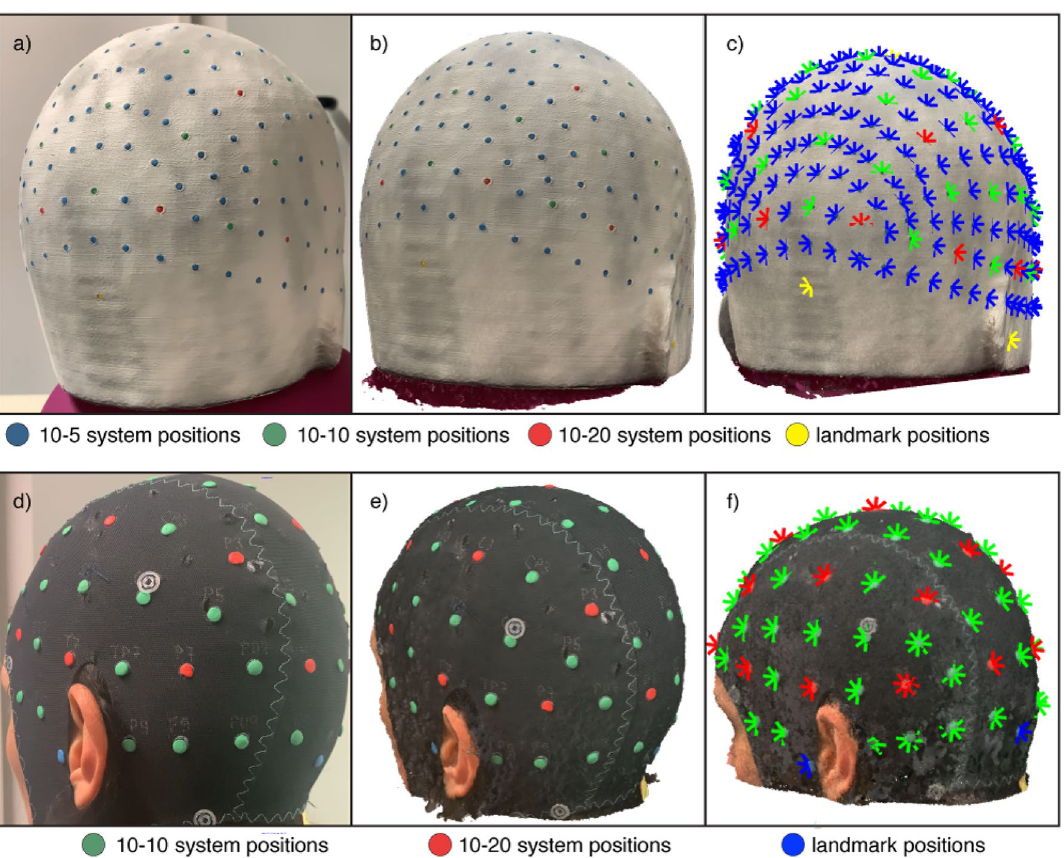
Figure 1. ( a ) Exemplary frame extracted from the recorded video of the phantom marked with the positions of the 10–5 EEG system. ( b ) Reconstructed 3D model of the head phantom obtained with the photogrammetry- based method. ( c ) Locations of the markers identified on the mesh of the phantom. ( d ) Exemplary frame extracted from the recorded video of one of the participants marked with the positions of the 10-10